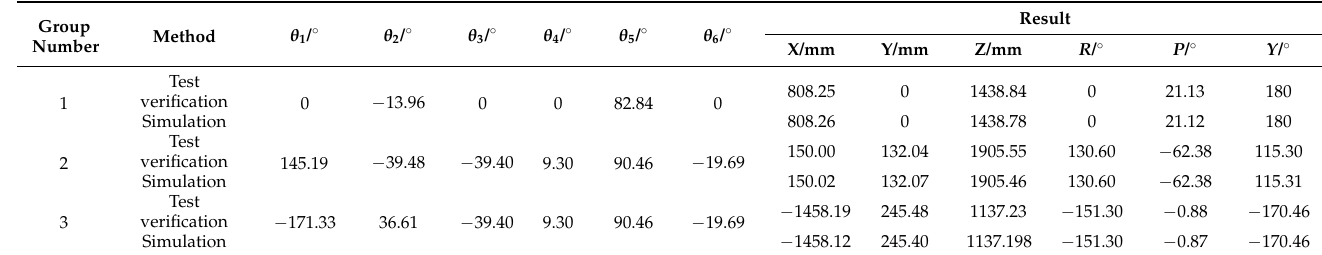
Table 5. The results of posture teaching and the end effector’s simulation